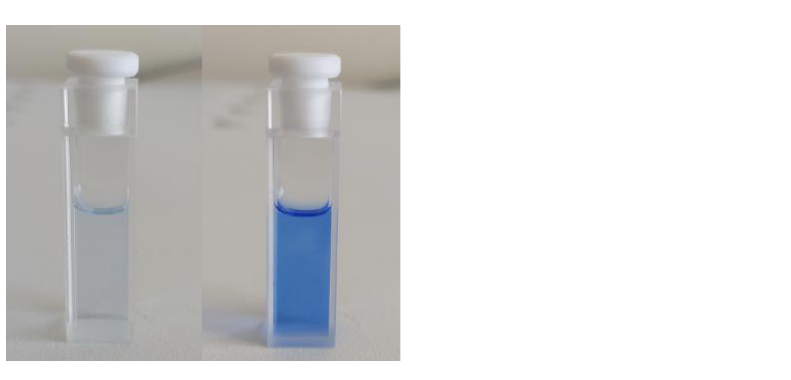
Figure 1. Absorption spectra of 22 in THF in spiropyran (1) and merocyanine forms (2 – 10) measured before (1) and upon UV irradiation (2) through a UFS-1 light filter and during bleaching in the dark (3 – 10). C = 10 −4 M, L = 0.1 cm.